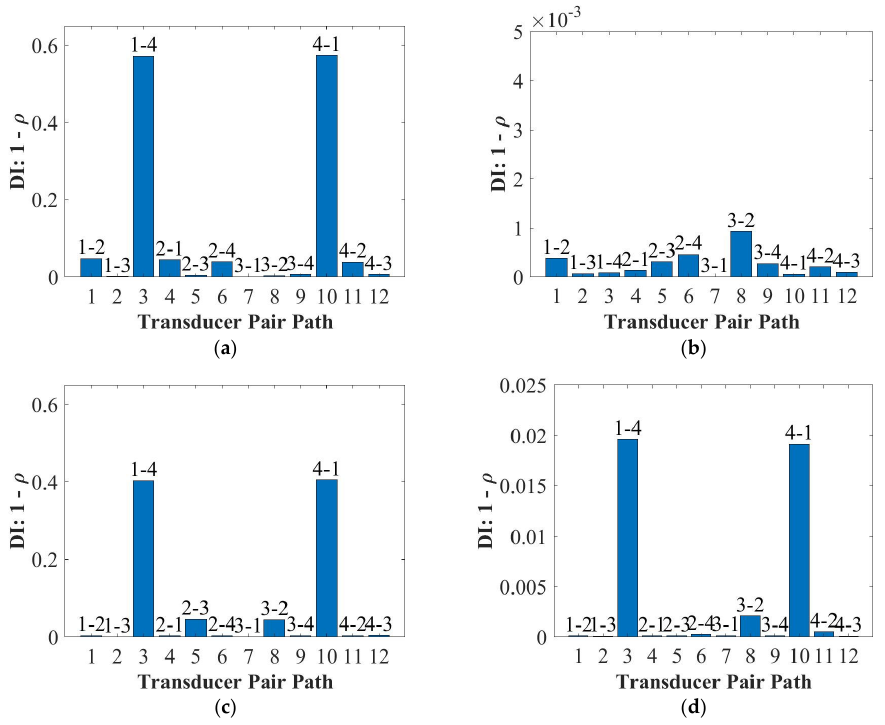
Figure A1. Damage detections for the 2 mm thick panel at 50 kHz ( a ) and 250 kHz ( b ) and for the 4 mm thick panel at 50 kHz ( c ) and 250 kHz ( d ).